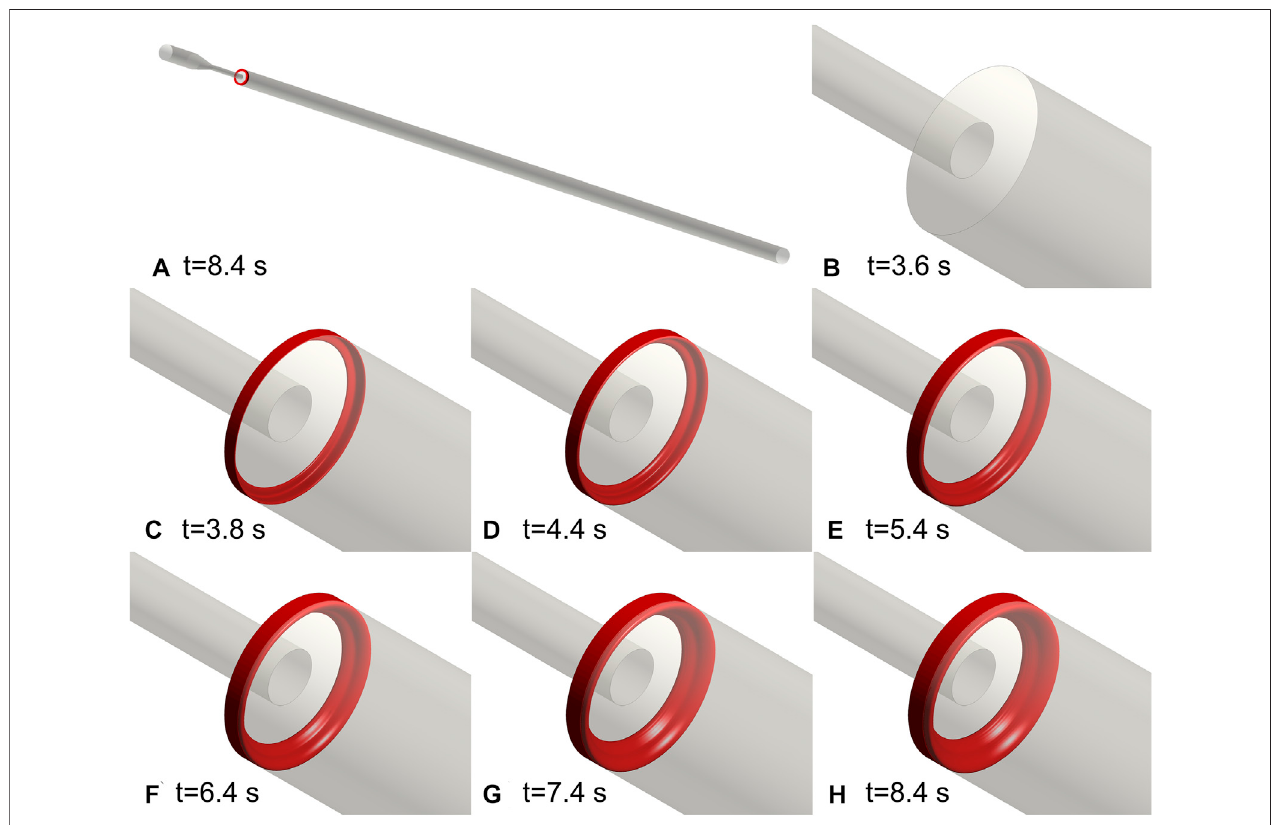
FIGURE 4 | Thrombus formation in the FDA benchmarknozzle. (A) Schematic diagram of the location ofthe thrombus. (B – H) Annular thrombosis process. All the activated platelets were consumed at 8.4 s and the thrombus reached its maximum volume. The fi nal thrombus is shaped like a ring.